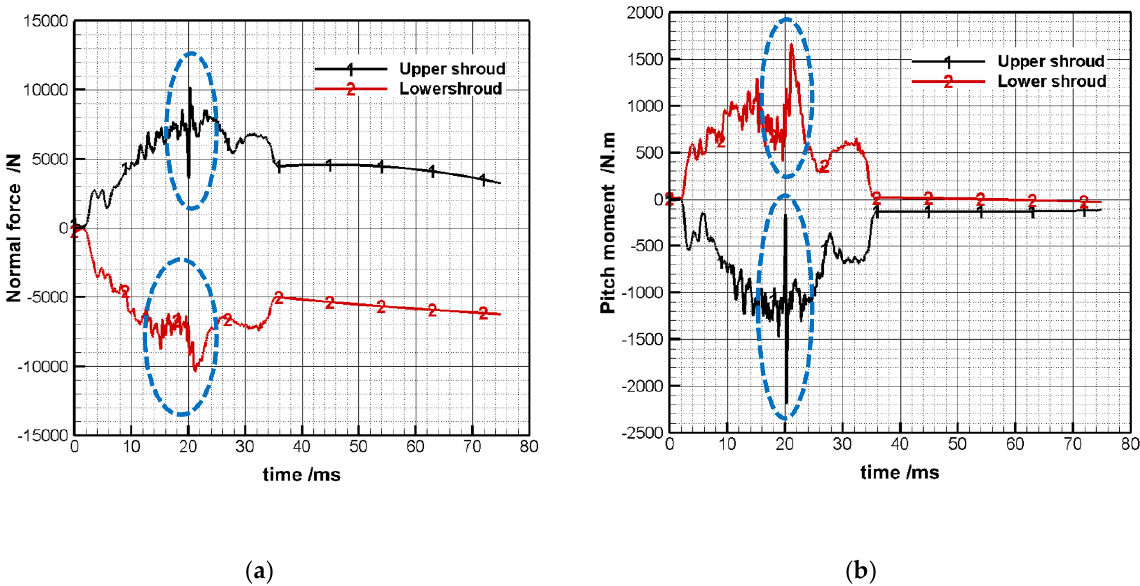
Figure 17. Aerodynamic characteristics of the shroud during the separation process: ( a ) normal force (Fz); ( b ) pitch moment. (The blue lines present a strong disturbance in the aerodynamic forces of shrouds.)